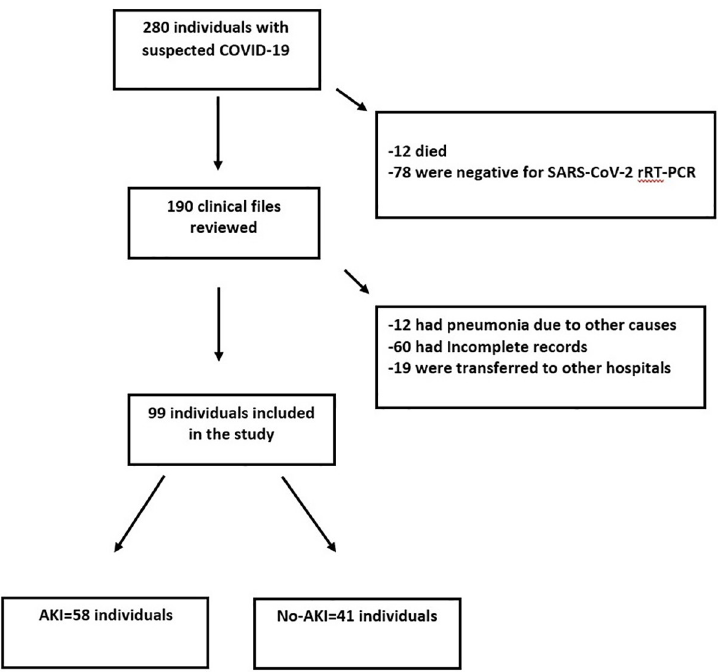
Fig 1. Study diagram. Numbers of individuals assessed for eligibility and individuals included in the study.